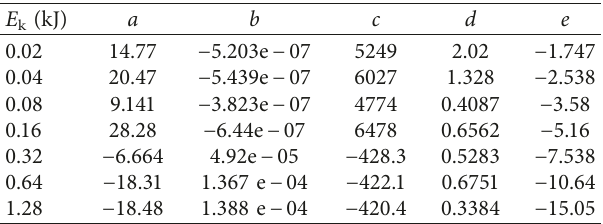
k and their corresponding real